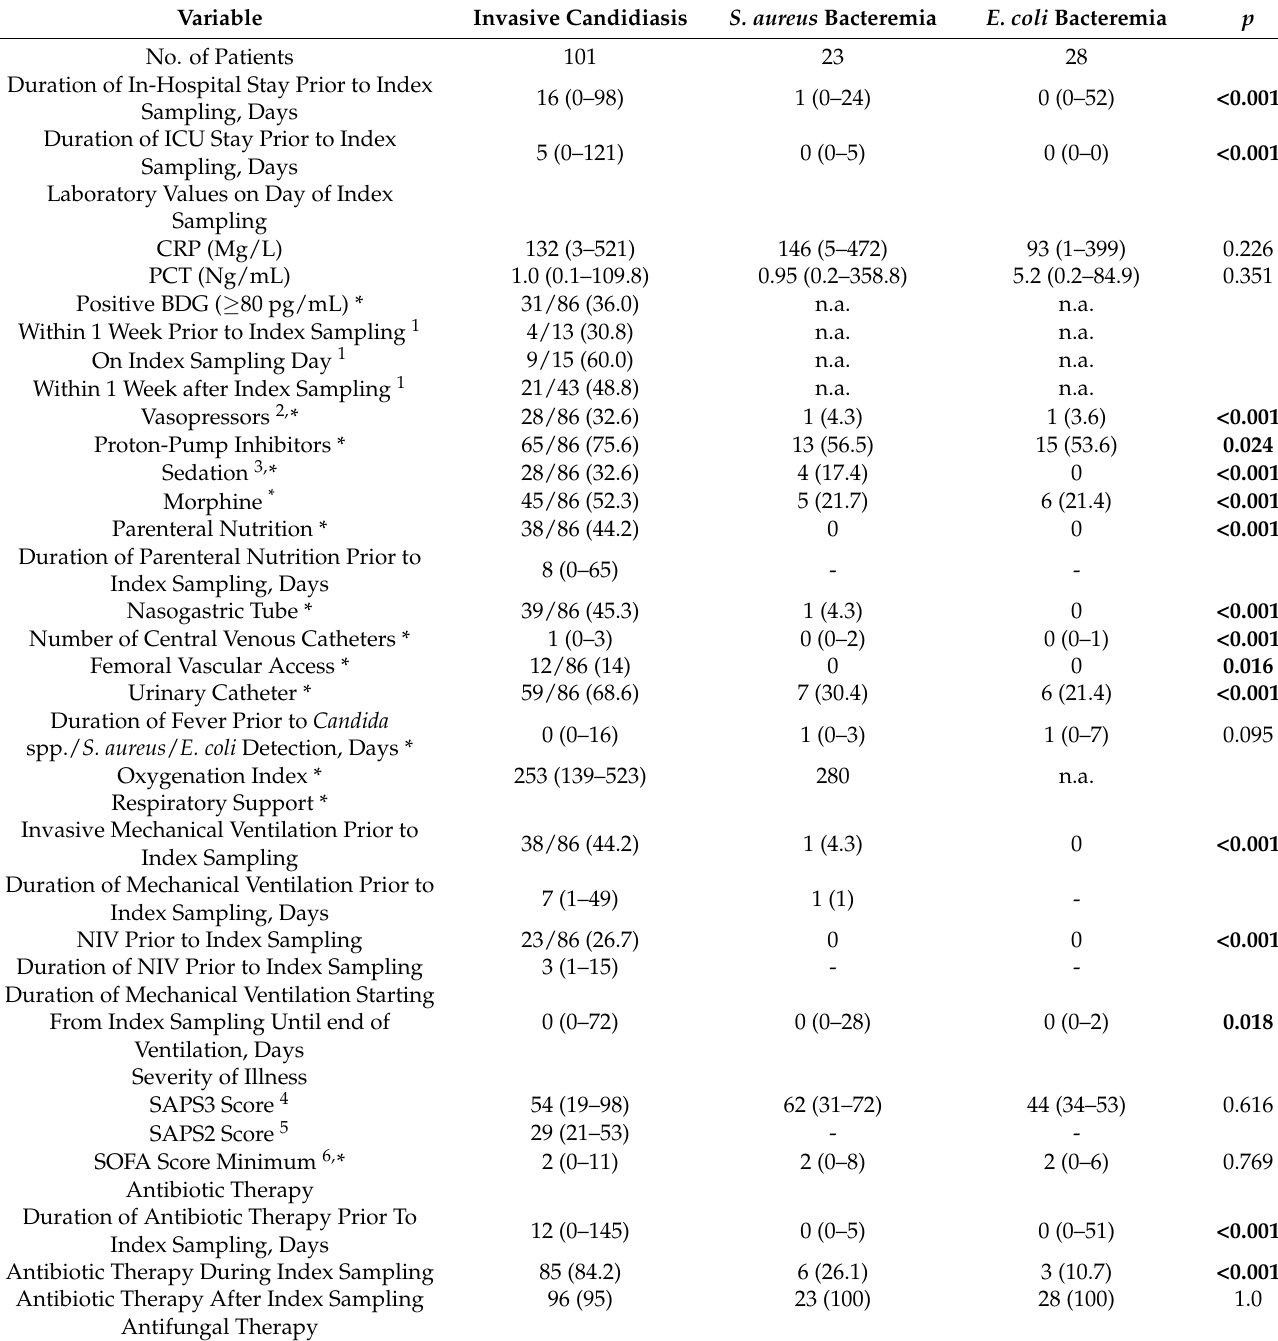
Table 3. Clinical characteristics of patients with invasive candidiasis, S. aureus bacteremia and E. coli bacteremia. Variable Invasive